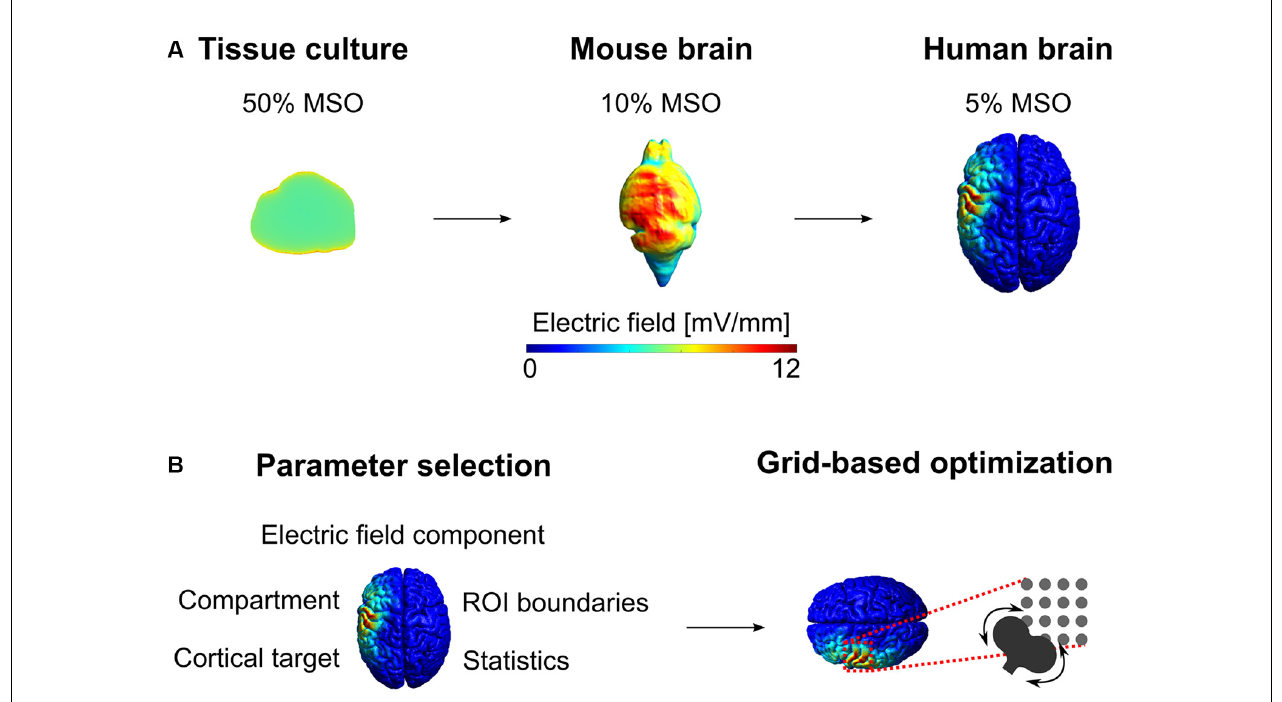
FIGURE 2 | Electric field modeling of in vitro tissue culture and in the mouse and human brain. (A) First, we estimated the electric field in the tissue culture produced by the figure-of-eight TMS coil at 50% of the maximum stimulator output (MSO). Then, we calculated the robust maximum (i.e., 99.9th percentile) of the electric field distribution in the tissue culture and optimized the stimulation intensities to reproduce the same robust maximum in the gray matter volume compartment. Due to the large difference between the brain volumes, the stimulator intensity (expressed in MSO%) is substantially weaker for the mouse and human brain. The spatial distribution of the electric field intensities is more homogenous in the tissue culture with simplified geometry compared to the mouse and human brain. The mesh file for the mouse brain was obtained from Alekseichuk et al. (2019). (B) The choice of simulation parameters influences the characteristics of the electric field and the outcome of the